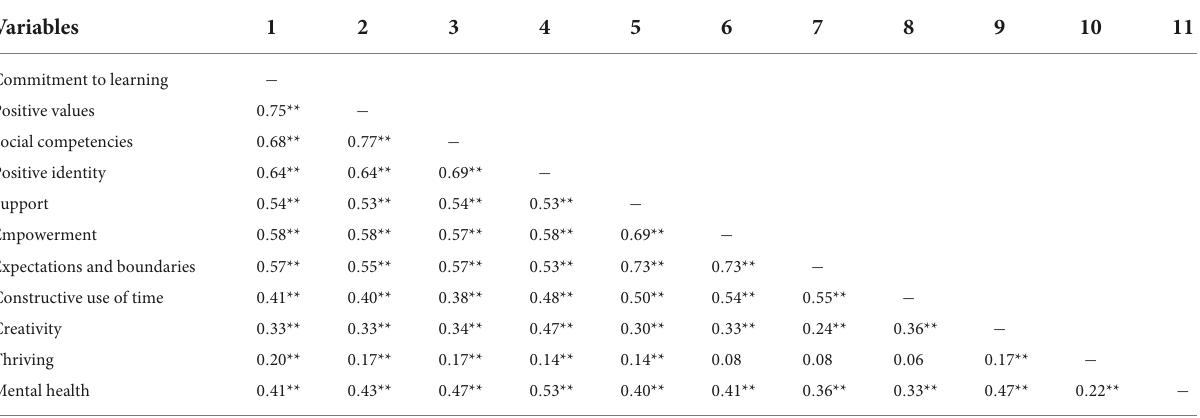
TABLE 3 Correlation analysis between developmental assets, creativity, thriving, and mental